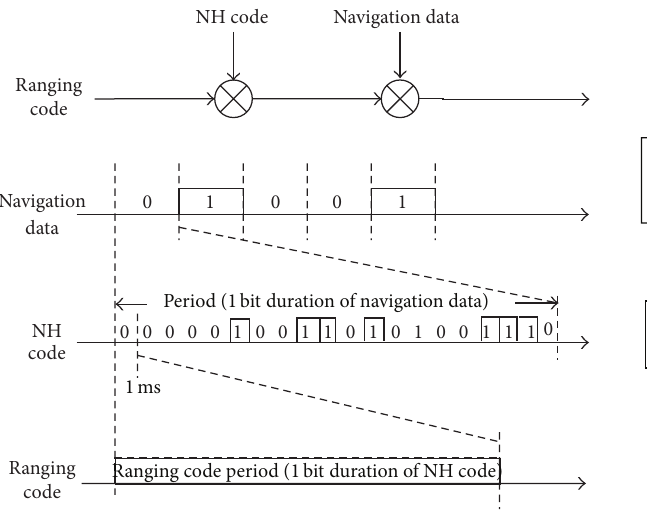
Figure 1: BDS CB1I NH code modulation.